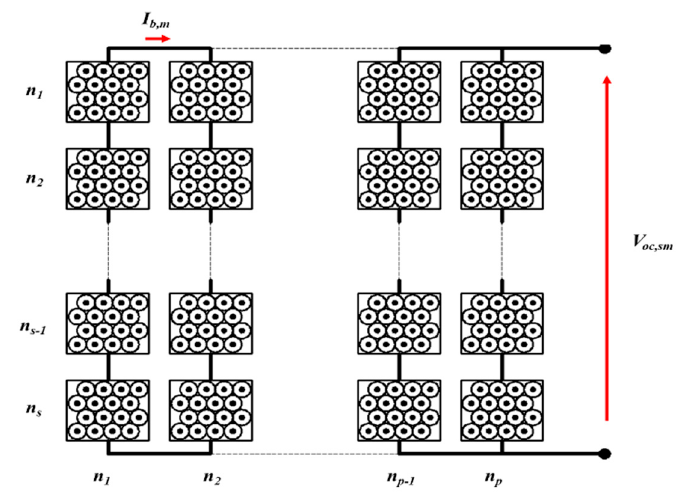
Figure 3. Scheme of a battery pack.